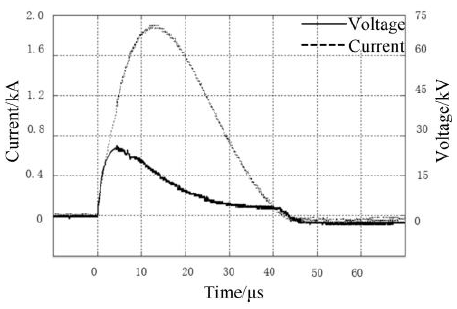
Figure 22. Current and voltage waveform of modified soil with the water content of 25% when injected into the impulse current.